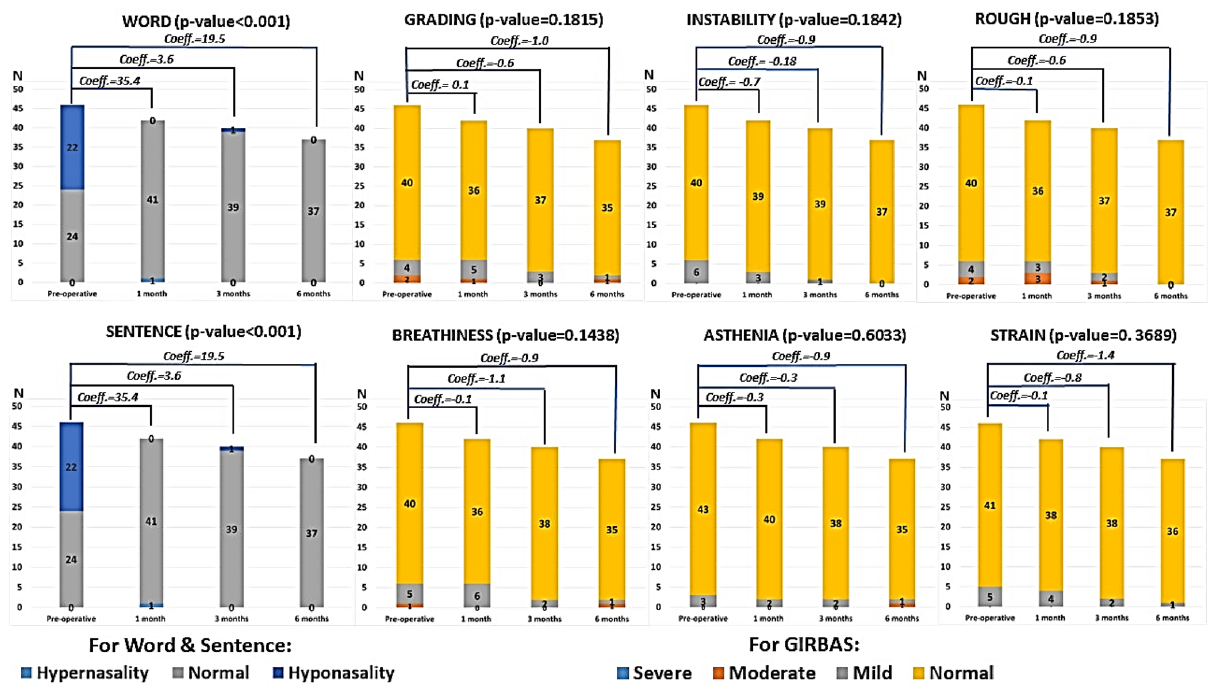
Figure 3. Subjective measurement of voice analysis showed that the number of patients who had the set word and sentence were improved from hypo to normal nasality at 1, 3 and 6 months after surgery (p < 0.001). The GIRBAS scale after surgery did not significantly change from prior surgery (p >